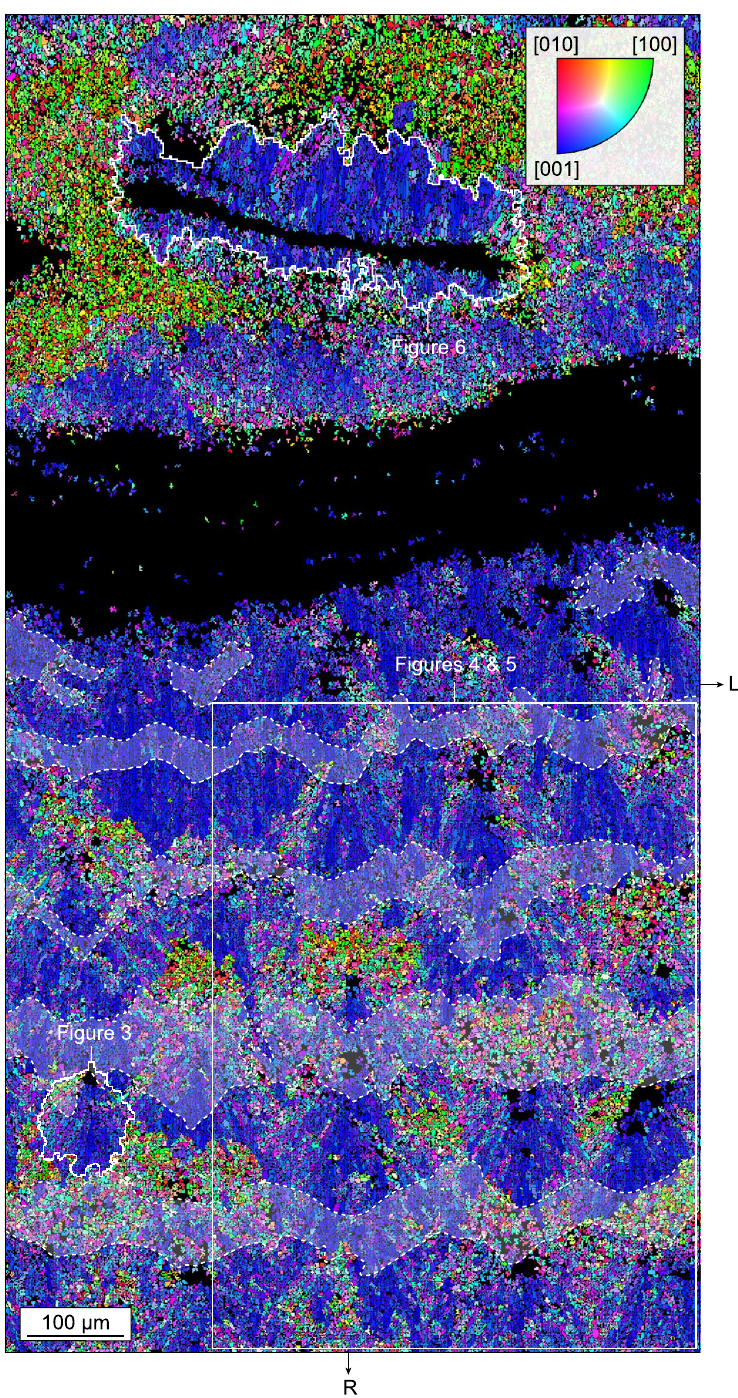
Figure 2. Crystal architecture of the skeleton wall. Inverse pole figure (IPF) map across the corallite wall of L. pertusa corresponding to the area displayed in Fig. 1d. The map shows the distribution of aragonite crystallographic axes with respect to the radial growth direction R of the corallite. The dominant bluish colour in the external part of the corallite wall (i.e. the TD area located in the lower half of the map) indicates that aragonite [001] axes are preferentially oriented parallel to R (within a tolerance of ~ ± 45°), i.e. normal to the corallite margin. The crystallites coloured in reddish and greenish are those for which the axes close to R are [010] and [100], respectively, i.e. those intersecting the acquisition surface at high angles. A distinctive feature of the internal part of the corallite wall (upper half of the map) is the RAD lamella from which aragonite needles are radiating along their [001] axes. RADs appear black because they did not produce any diffraction pattern, possibly because of poor crystallinity and/or small crystal size. Optically opaque bands identified in Fig. 1d have been superimposed in light grey and delimited by dashed lines. R and L as in Fig.